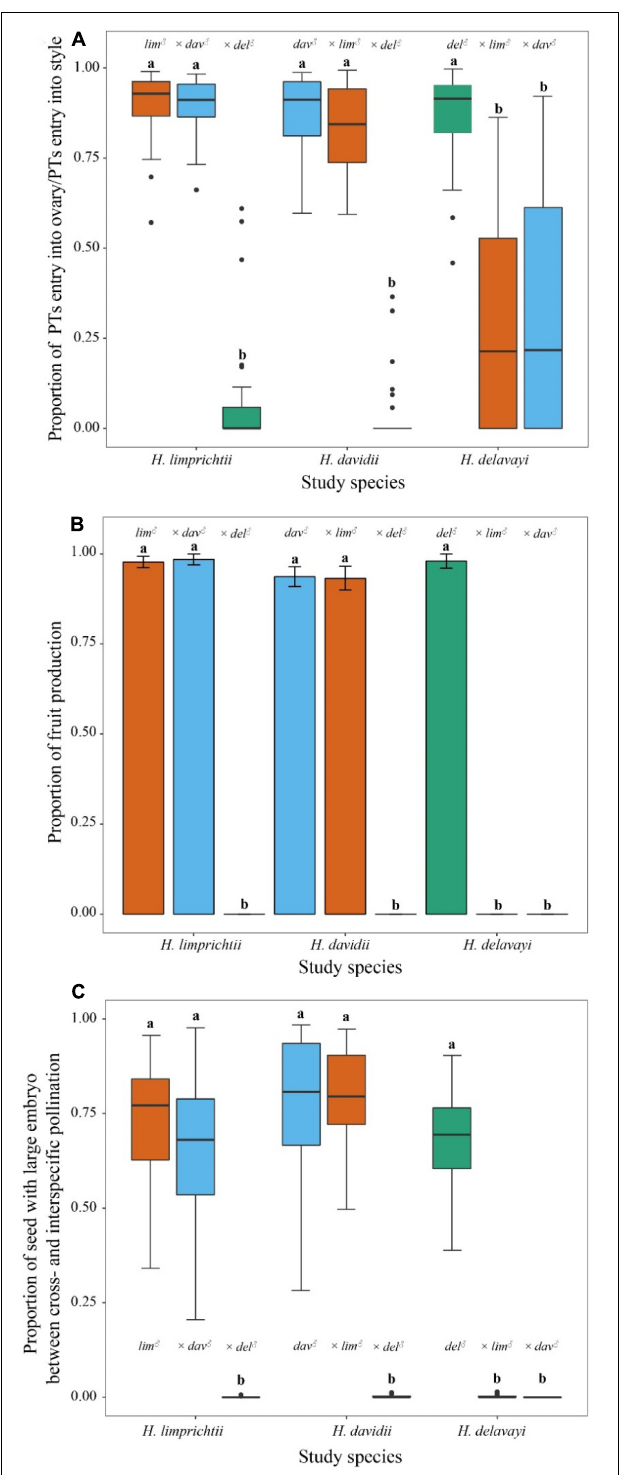
FIGURE 5 | The effect of intra- and interspecific cross-type on (A) the proportion of pollen tubes entering into styles and ovary; (B) a number of fruits produced; and (C) the proportion of seed with large embryos among three Habenaria orchids. Lower case letters indicate significant differences at p < 0.001. lim , Habenaria limprichtii , dav , H. davidii , del , H. delavayi